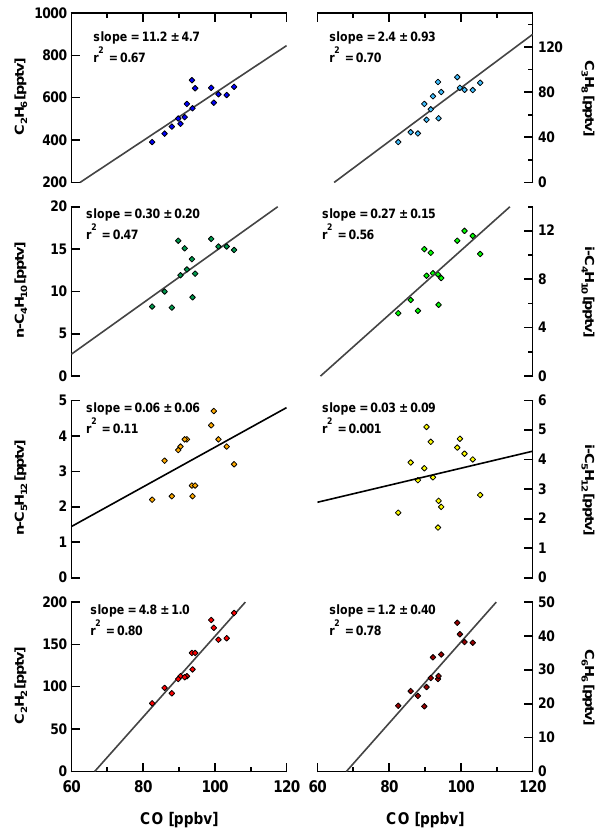
Fig. 5. Correlation plots of observed mixing ratios of NMHCs with CO in fresh (3–5 day transport times; see text) monsoon outflow during July and August. Slopes of the correlation have units of pptv NMHC/ppbv CO and the uncertainty represents the 95% confidence interval of the